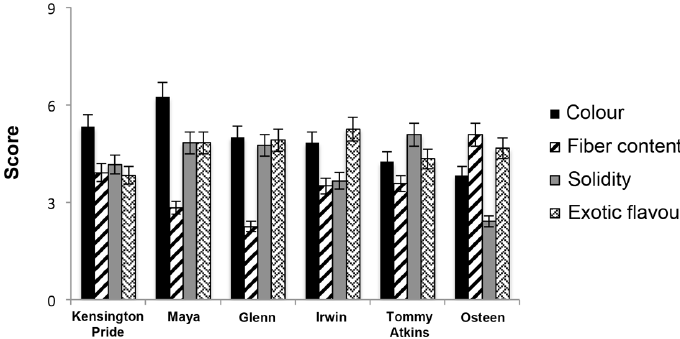
Figure 4. Sensory descriptors of six varieties of Sicilian mango. The panel evaluation was performed in a scale from 1 (extremely dislike) to 9 (extremely like). Data reported in the figure were extrapolated by previous studies performed by Farina et al. [81].